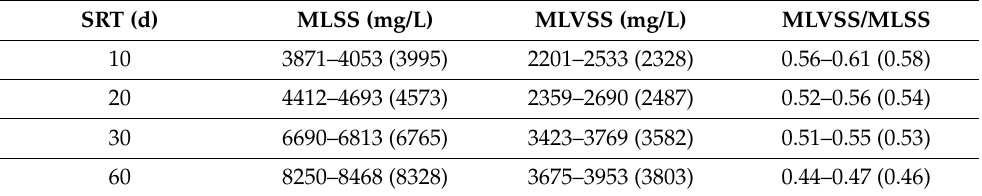
Table 2. Activated sludge concentration under different SRT